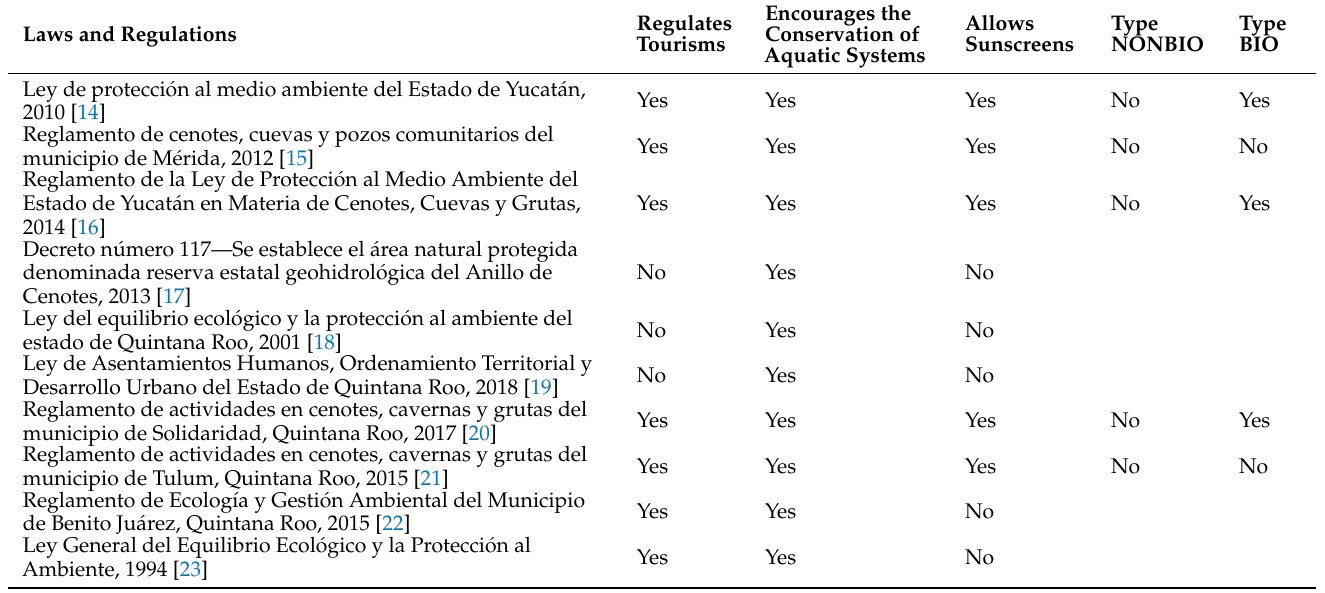
In the state of Yucat á n, biodegradable sunscreens are permitted in sinkholes through- out the state, except in the state capital, M é rida, where no sunscreen is permitted inside the sinkholes. Finally, in the state of Campeche, there is currently no legislation that regulates or protects the quality of the water in the sinkholes (Table 2). Table 2. Laws and regulations on state and municipal regulations of the Yucatan peninsula, about the use of sunscreen. Laws and